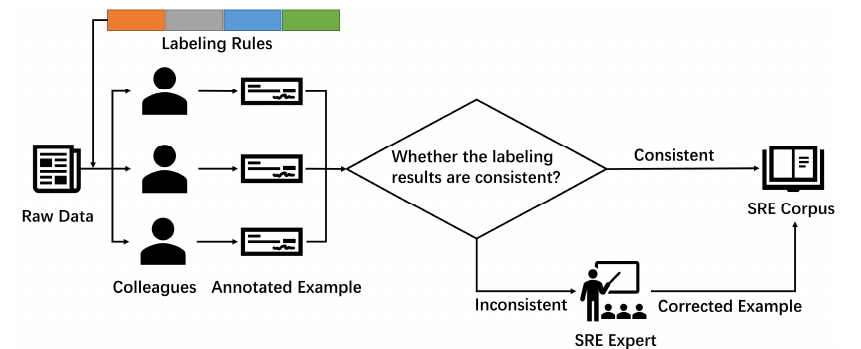
Figure 2. Arbitration‑based approach to corpus annotation and corpus quality enhancement.